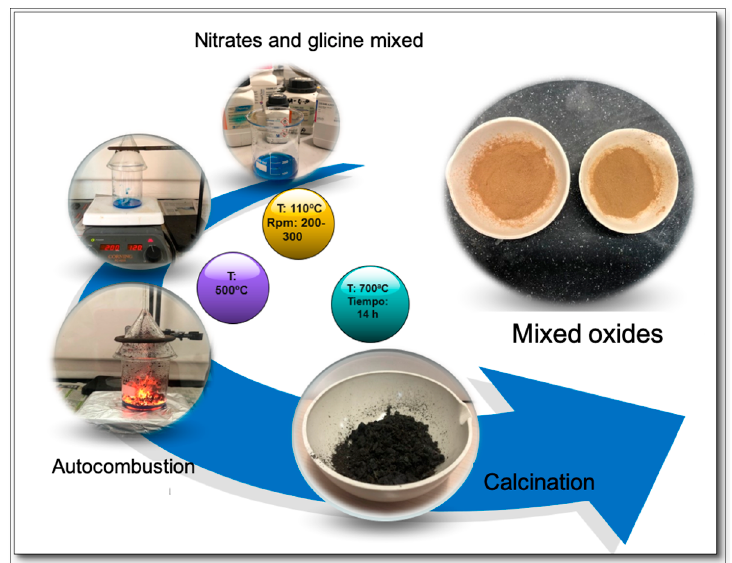
Figure 8. Procedure for catalysts synthesis using the autocombustión technique .